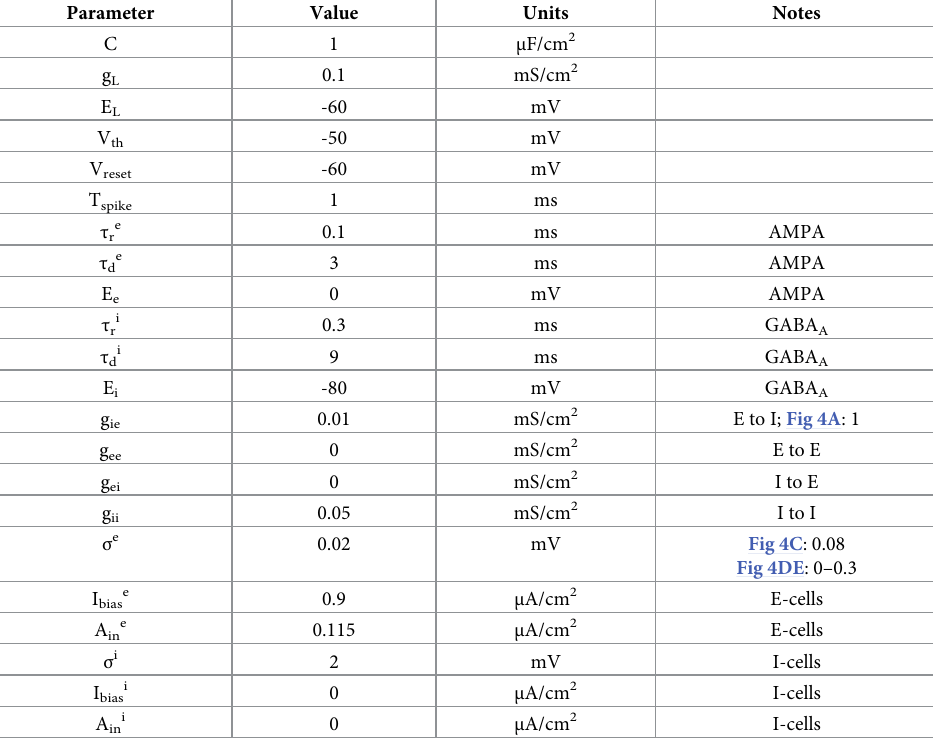
Table 2. Parameters used for modeling inheritance of spiking resonance generated by an isolated LIF (Fig 4). Parameter